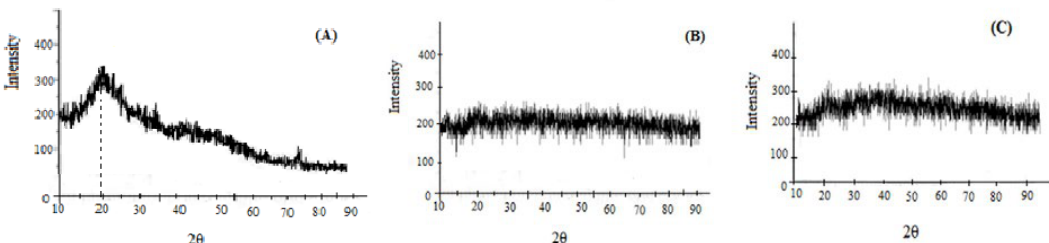
Figure 3: XRD patterns of GT (A), Bassorin (B) and Bassorin/PEO (C) Fig. 3: XRD patterns of GT (A), Bassorin (B) and Bassorin/PEO (C)